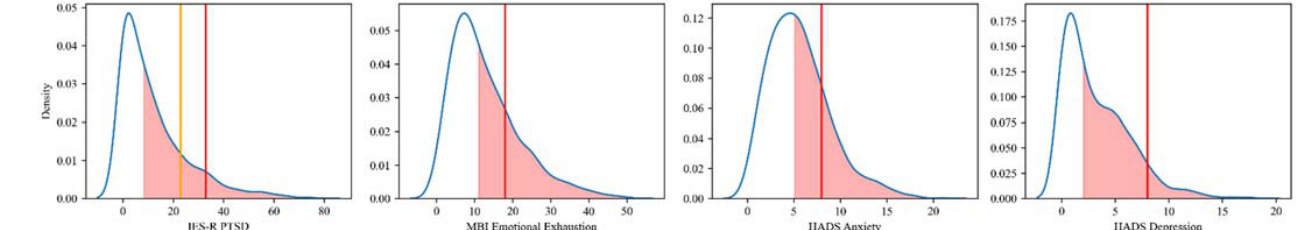
Figure 1. Distributions of pathological scores and cutoffs (vertical lines) for each of the scales (left to right) IES ‐ R PTSD (clinical concern ≥ 24 in orange; 16% and positivity ≥ 33 in red; 9%), MBI Emotional Exhaustion ( ≥ 18), HADS Anxiety ( ≥ 8), HADS Depression ( ≥ 8) Scales. The red shaded area denotes where the upper 50% of police officers are situated (the median and above). The area to the right of the vertical lines designates pathology presence (e.g., ≥ threshold).